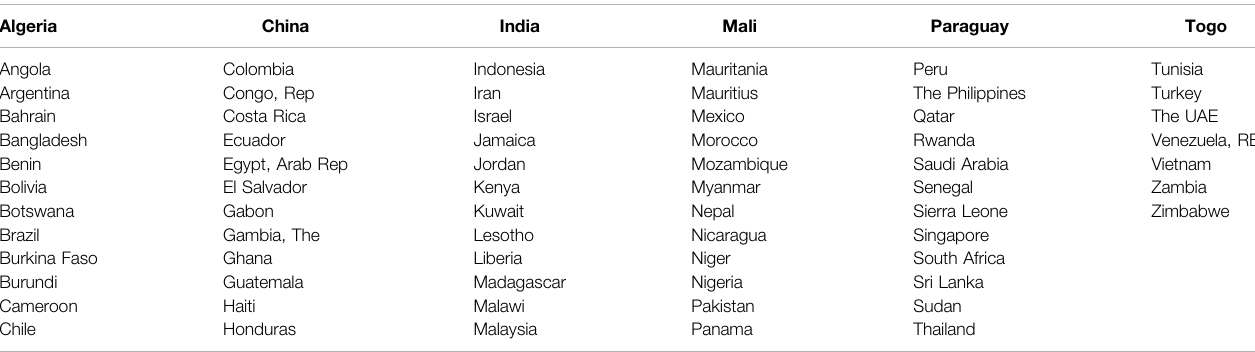
TABLE A1 | Developing countries